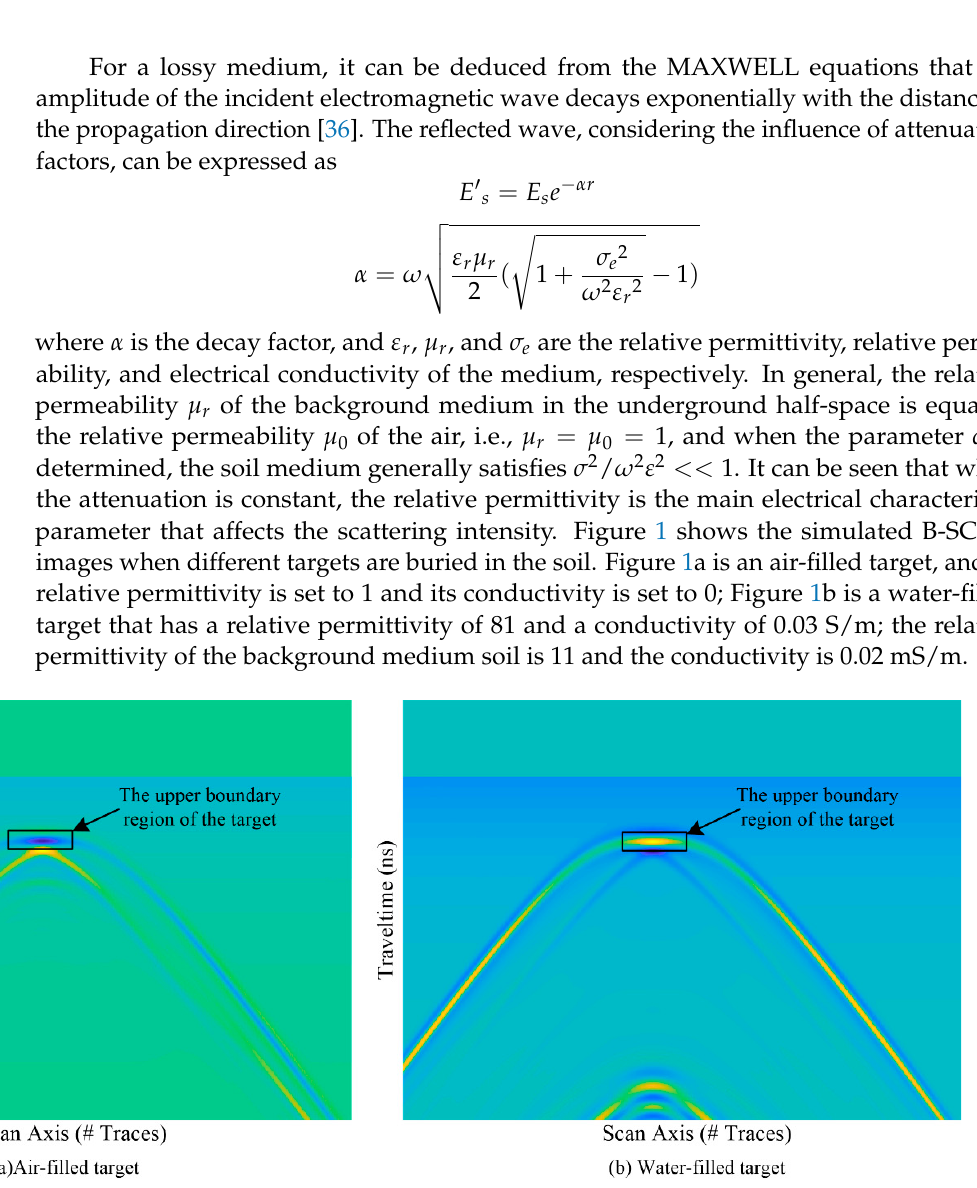
Figure 1. GPR B-SCAN images.